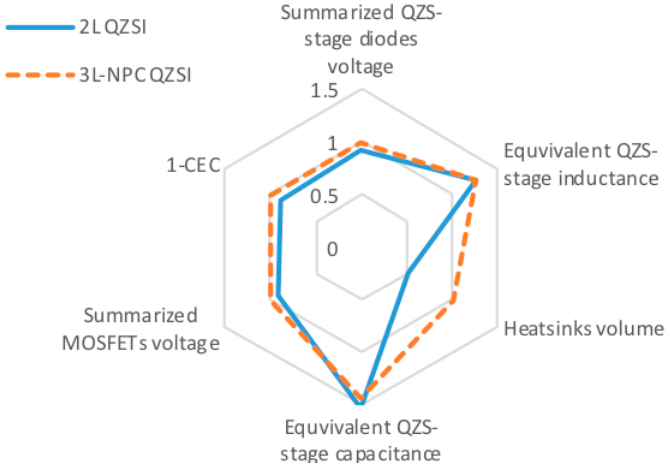
Figure 12. Comparative diagram for the 2L QZSI and 3L NPC QZSI.